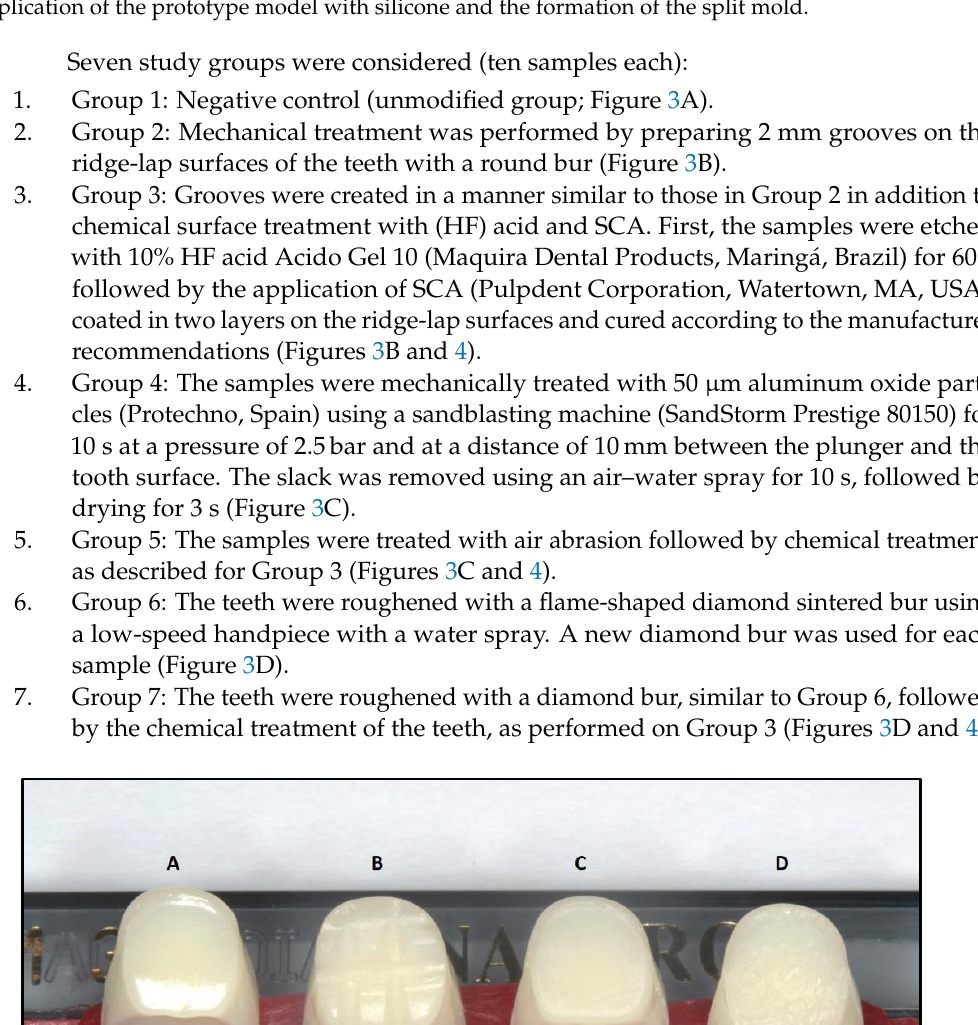
Figure 2. Duplication of the prototype model with silicone and the formation of the split mold.